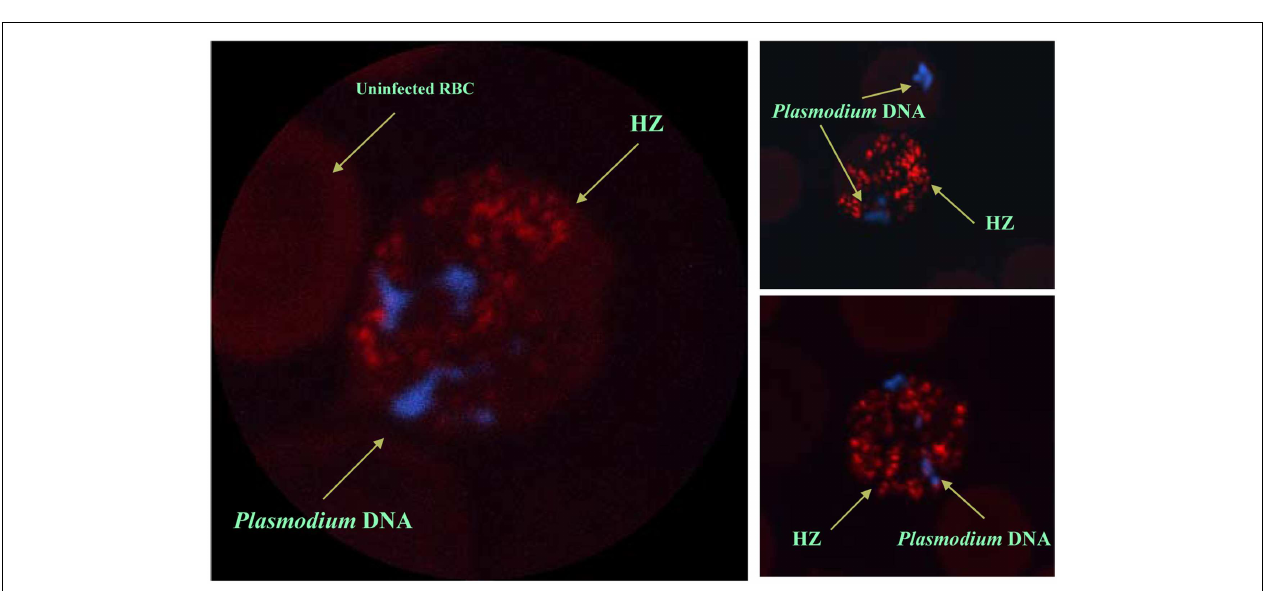
No staining was required to localize HZ since it autofluorescences (red). Even after merozoite release from the iRBC (see top right panel), malarial DNA was never in contact with hemozoin. Images were taken from Ref.